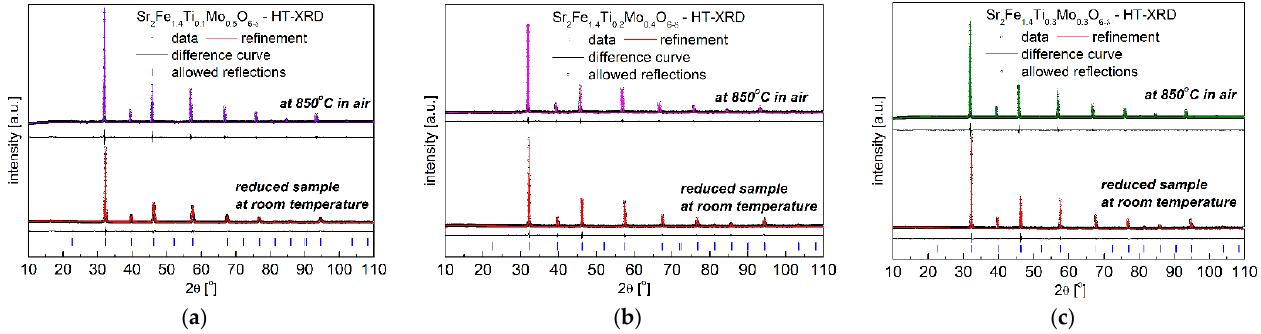
Figure 5. XRD patterns recorded at 30 °C and 850 °C in air for reduced ( a ) Sr 2 Fe 1 . 4 Ti 0 . 1 Mo 0 . 5 O 6 −δ ; ( b ) Sr 2 Fe 1 . 4 Ti 0 . 2 Mo 0 . 4 O 6 −δ and ( c ) Sr 2 Fe 1 . 4 Ti 0 . 3 Mo 0 . 3 O 6 −δ .